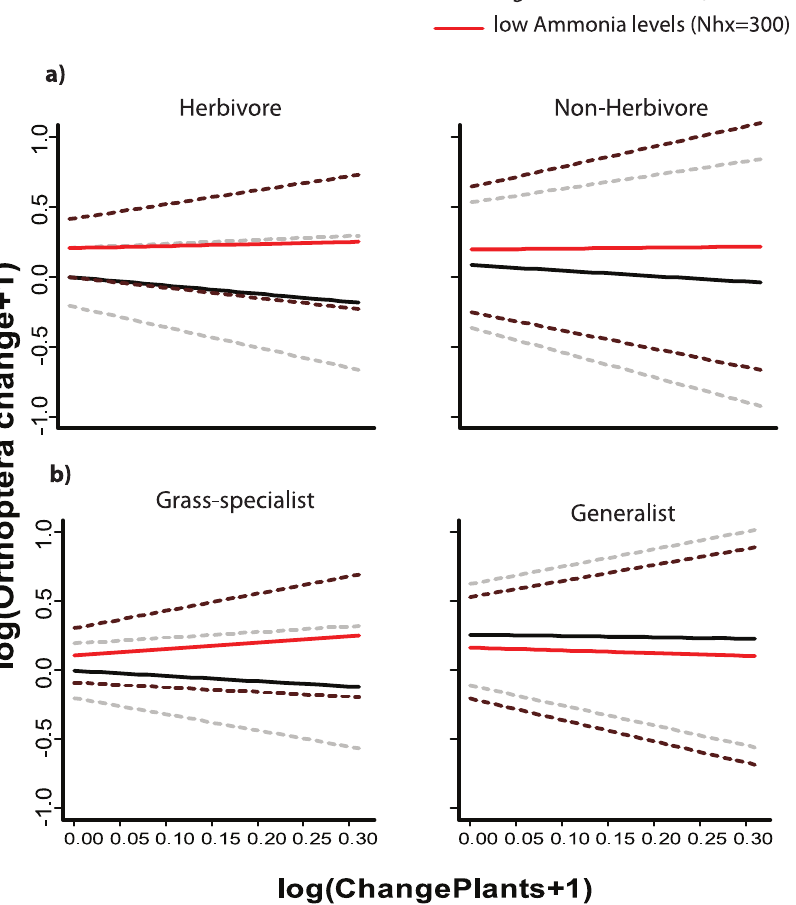
Figure 5. Orthoptera species richness change ( + 2 SD, dashed lines) against plant species change at low versus high nitrogen levels (food trait subgroups). All comparisons between the second (1976–1990) and third time period (1996–2010) and in 10 km grid cells. The black lines show the estimated values for Orthoptera under a fixed value of ammonia; the grey lines represent the 95% confidence intervals. Ammonia levels in